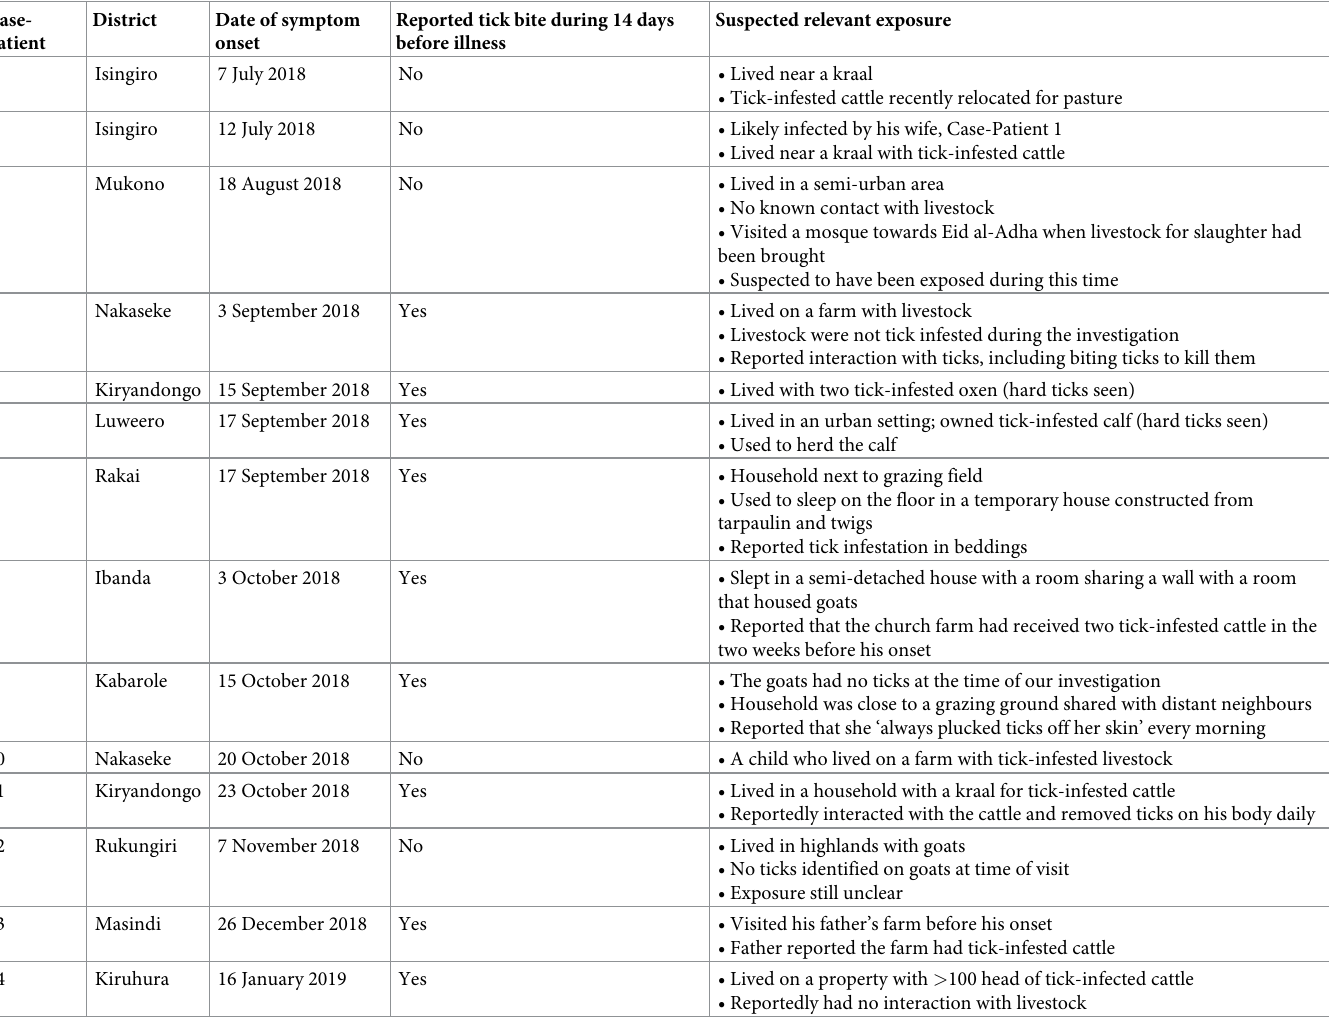
Table 1. Exposure information for case-patients with confirmed Crimean-Congo haemorrhagic fever during July 2018 to January 2019 in Western and Central Uganda. Case-